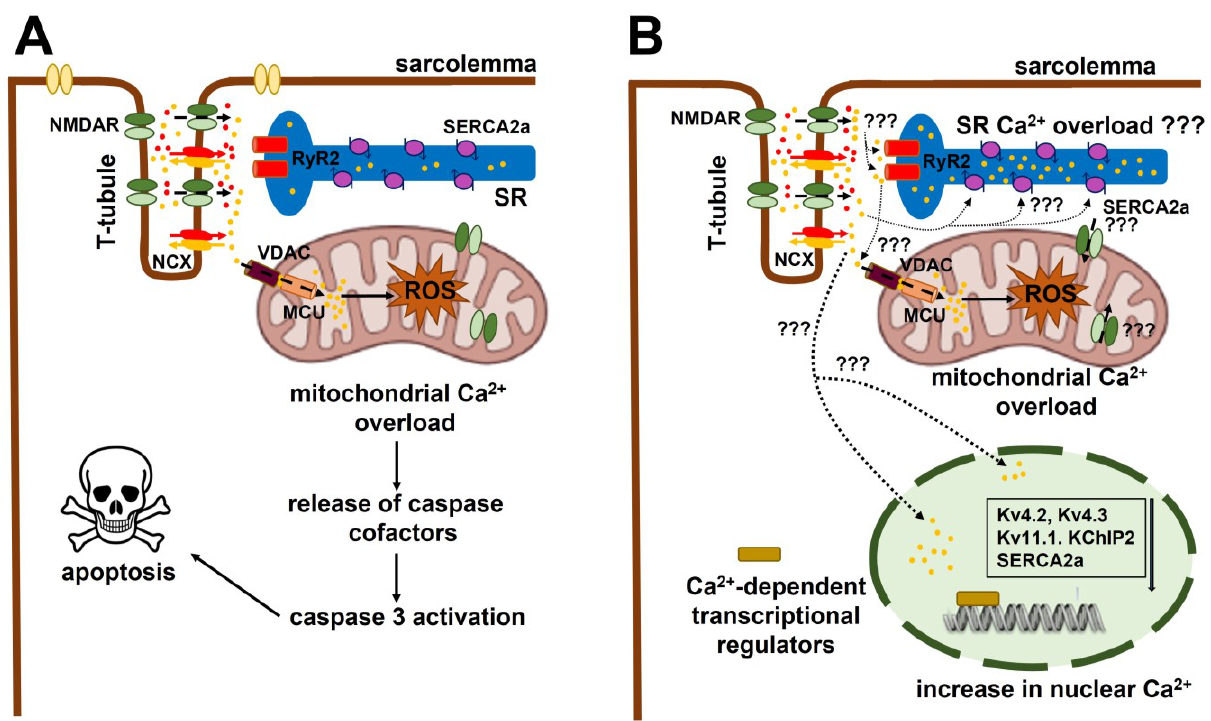
Figure 3. NMDAR-mediated extracellular Ca 2+ entry may result in mitochondrial Ca 2+ overload and caspase 3-dependent apoptosis in ventricular cardiomyocytes. ( A ) Extracellular Ca 2+ entry through NMDARs may result in mitochondrial Ca 2+ overload by flowing through voltage-dependent anion channels (VDAC) and mitochondrial Ca 2+ uniporters (MCU), which are located in the outer and inner mitochondrial membranes, respectively. The mitochondrial Ca 2+ overload may, in turn, lead to the formation of the mitochondria permeability transition pore (mPTP) (not shown), release of caspase cofactors, caspase 3 activation, and cell death. In addition, NMDAR opening can induce depolarization via the influx of Na + and Ca 2+ , which could promote further depolarization via activation of the Na + /Ca 2+ exchanger (NCX). Recent evidence detected NMDARs in the Z-disc, which is juxtaposed to the T-tubules. ( B ) Extracellular Ca 2+ entry through NMDARs in ventricular cardiomyocytes could either promote CICR via RyR2 (denoted by “ ??? ” ) or lead to SR Ca 2+ overload in a SERCA2a-dependent manner (denoted by ???). We hypothesize that SR-dependent Ca 2+ release via RyR2 could further contribute to mitochondrial Ca 2+ overload (denoted by “ ??? ” ). Finally, NMDAR-mediated extracellular Ca 2+ entry could also induce an increase in nucleoplasmic Ca 2+ and thereby down-regulate the expression of K v 4.2, K v 4.3, K v 11.1, and KChIP2 through Ca 2+ -dependent tran-